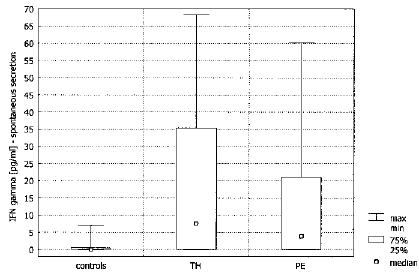
FIG. 3. Comparison of IL-10 spontaneous secretion in healthy pregnant women (controls) ( n = 11), and pregnant women with transient hypertension (TH) ( n = 17) and pre-eclampsia (PE) ( n = 21). Statistically significant are the differences between controls and PE ( p < 0.05).